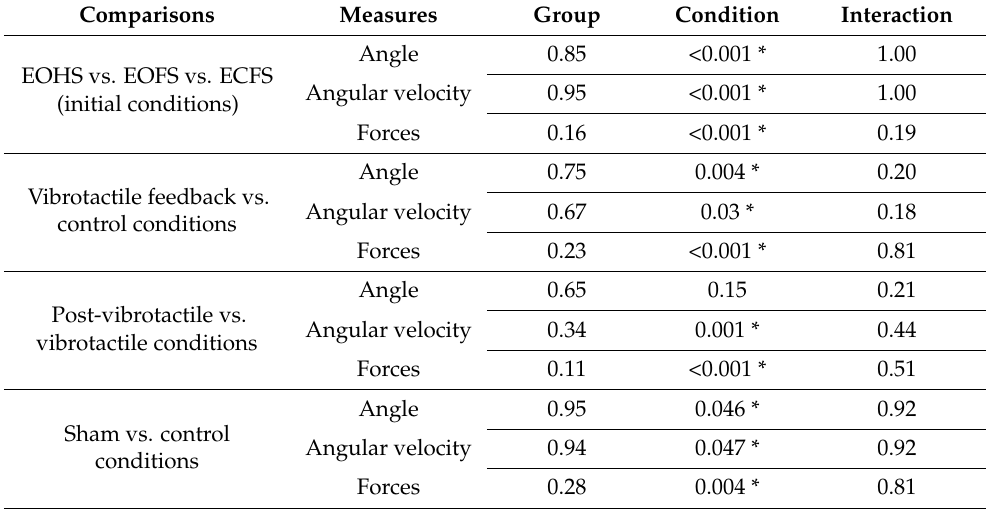
Table A2. Statistics (i.e., p values), for the area of the ellipse covering the body sway angle, angular velocity, or ground reaction forces, for the main effect of Group, Condition and the interaction Group by Condition. The asterisks (*) indicate significant differences between